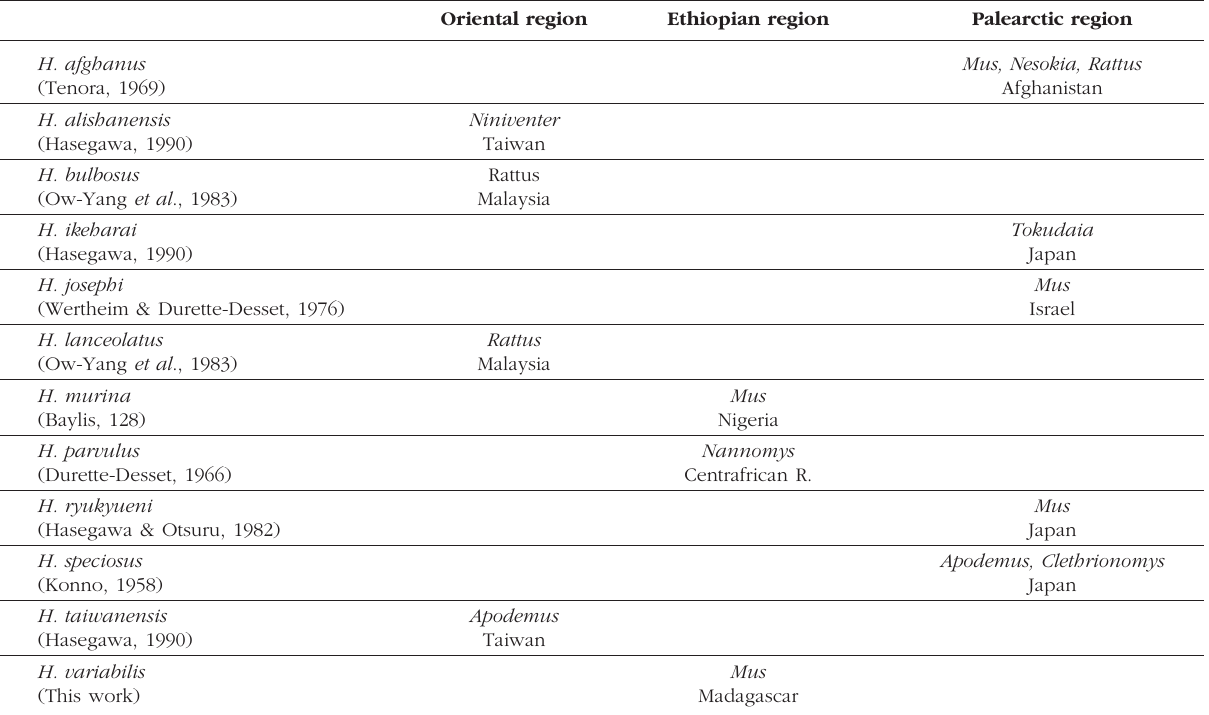
Table I. – Host spectrum and biogeographic distribution of the species of the genus Heligmonoides Baylis,